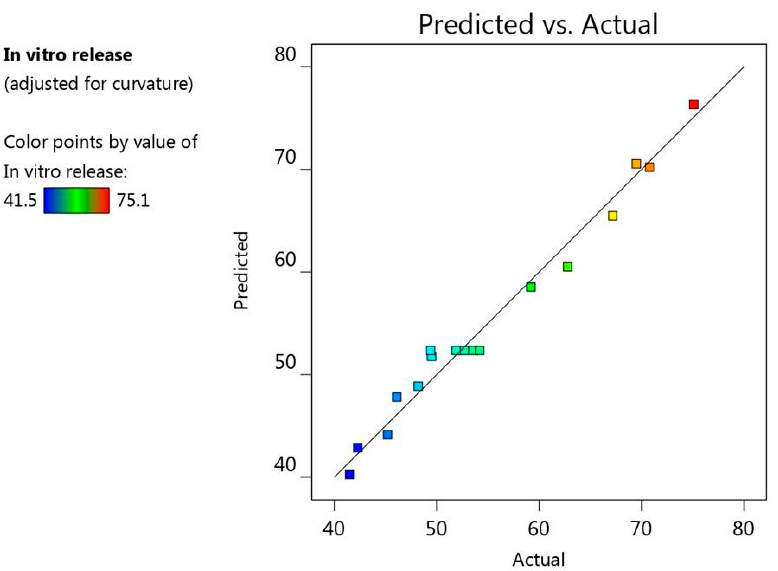
Figure 9. Linear correlation plot between actual and predicted values for in vitro release response